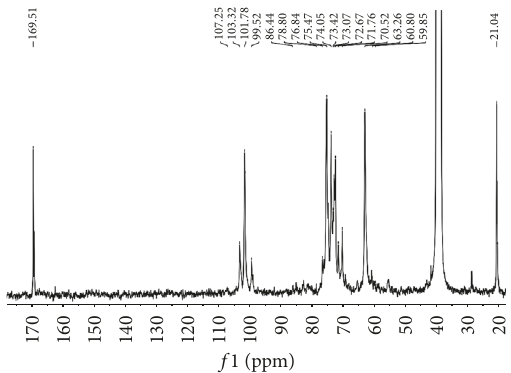
Figure 5: 13 C NMR spectrum of hemicellulosic fraction H 50